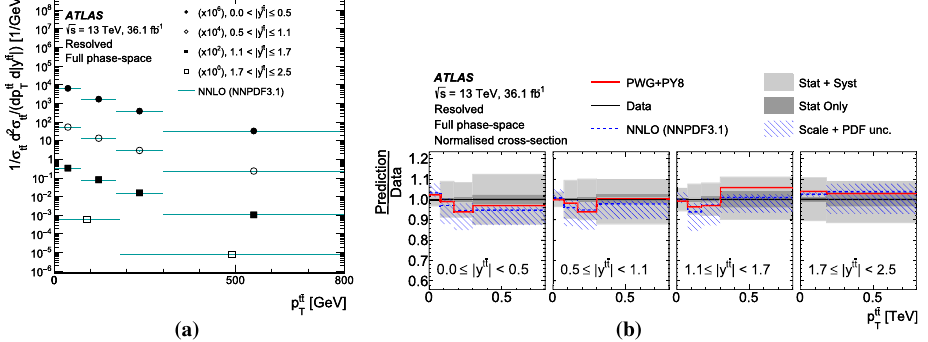
Fig. 61 a Parton-level normalised differential cross-section as a func- (cid:7) (cid:7) (cid:7) y t ¯ t (cid:7) in the resolved topology compared with the tion of p t ¯ t in bins of T NNLO prediction obtained using the NNPDF3.1 NNLO PDF set. Data points are placed at the centre of each bin. b The ratio of the measured